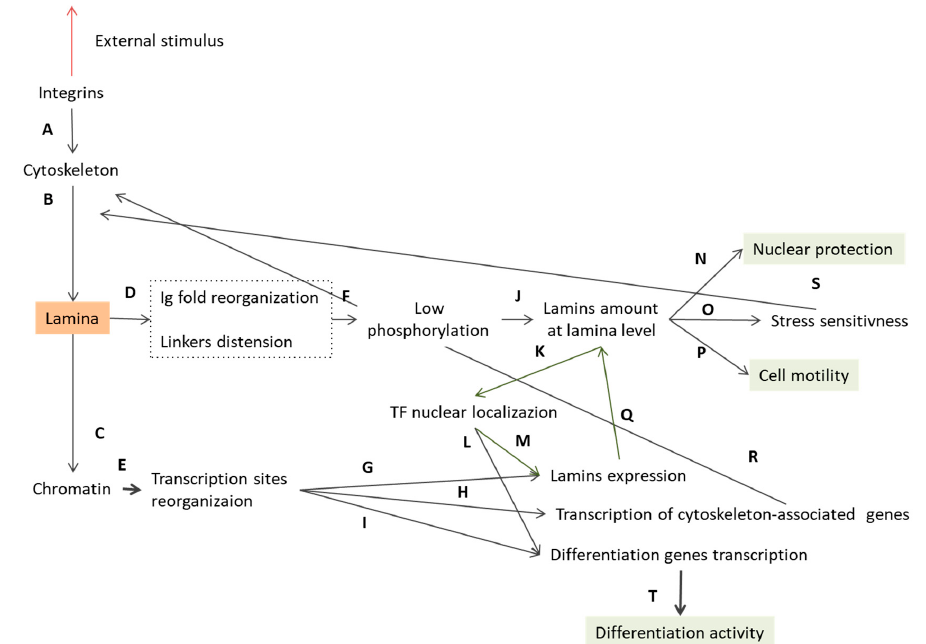
Figure 6. The role of lamina in mechanotransduction. Starting from the extracellular matrix, integrins transmit the external impulse to the cytoskeleton ( A ), which then transfers the stimulus to the lamina structure ( B ). The lamins first act as a mechanosensor and rearrange their molecular structures ( D ), hiding the sites for phosphorylation ( F ). The inhibited phosphorylation activity increases the amount of lamins at the nuclear envelope with a consequent increase in lamina stiffness ( J ). At this level, the lamina mesh guarantees the nuclear protection ( N ) and higher stress sensitivity ( O ), which impact on the rearrangement of the lamina ( S ) and affect cell motility ( P ). Lamina rearrangement is correlated to the higher nuclear localization of some transcription factors ( K ), whose activity is also enhanced by the alteration in chromatin structure ( C ). The rearrangement of the lamina leads to a reorganization of the chromatin ( C ), thus altering the sites available to the transcription factors ( E ) for lamins ( G ), cytoskeleton ( H ), and differentiation genes ( I ). The reorganization of the chromatin sites and the higher nuclear availability of transcription factors alter the transcription of the lamins ( M , G ) which thus provides feedback on the lamina stiffness ( Q ). The chromatin reorganization also acts on the transcription of the cytoskeleton components ( H ), which in turn affects the force transmission to the lamina at the upstream level ( R ). To conclude, the chromatin reorganization affects the differentiation gene transcription ( I ), which, combined with the increased transcription factor nuclear localization ( L ), act on cell differentiation activity ( T ). Orange is used to highlight the key position of the lamina at the crossroads of the mechanotransduction pathway, and green highlights all the revealed downstream effects of the lamina reorganization. Green arrows represent the lamins feedback loop.